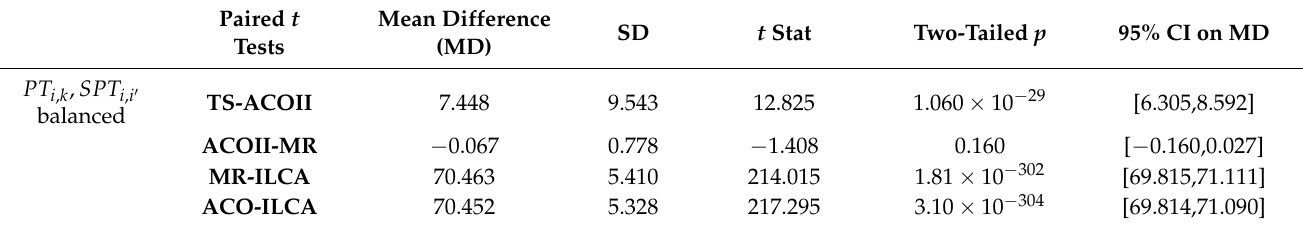
Table 3. Paired t -tests with 95%